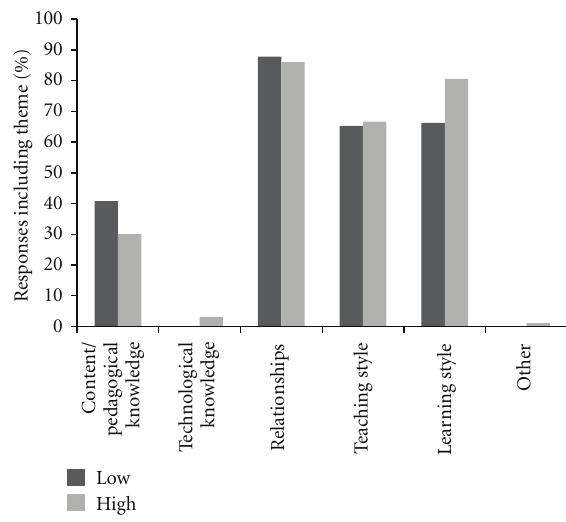
Figure 6: Patterns of themes by integration level for the personal characteristics of people who are excellent